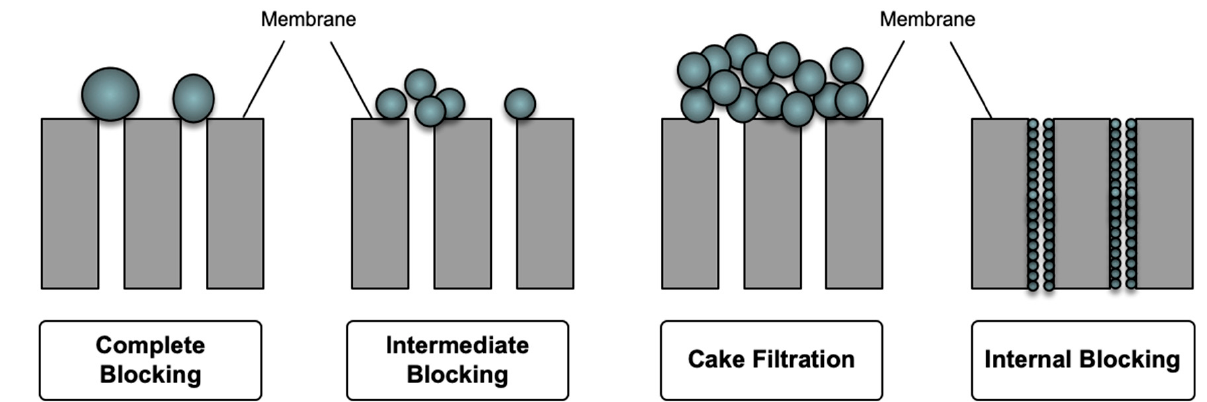
Figure 9. Schematic of membrane fouling mechanisms.